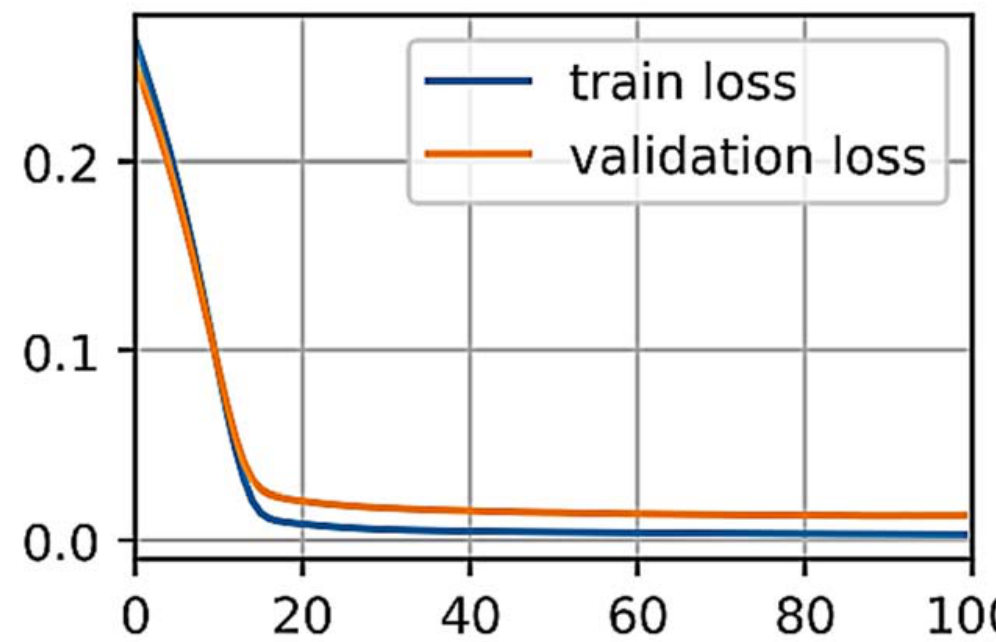
Figure 9. Loss function over training epochs.